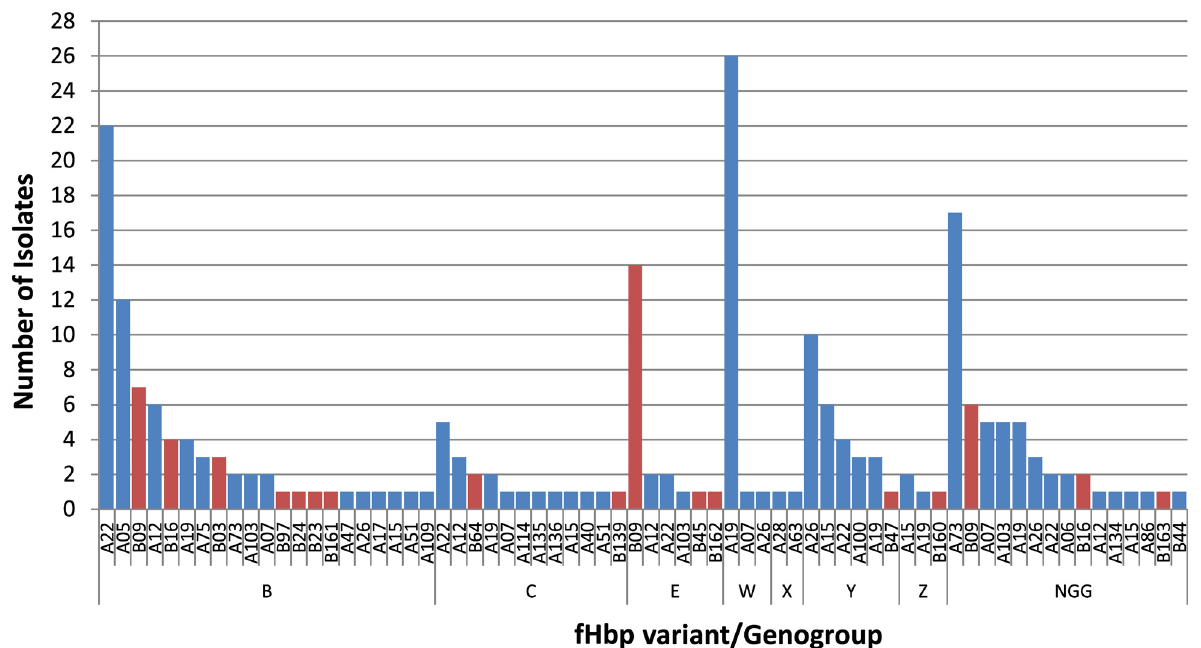
Fig 3. Distribution of the fHbp variants by genogroup in the carriage isolate collection. Carriage isolates were categorized by fHbp variant within each genogroup and are shown according to number of isolates identified. Blue bars, fHbp subfamily A variants; red bars, fHbp subfamily B variants. NGG, nongenogroupable by rt-PCR.